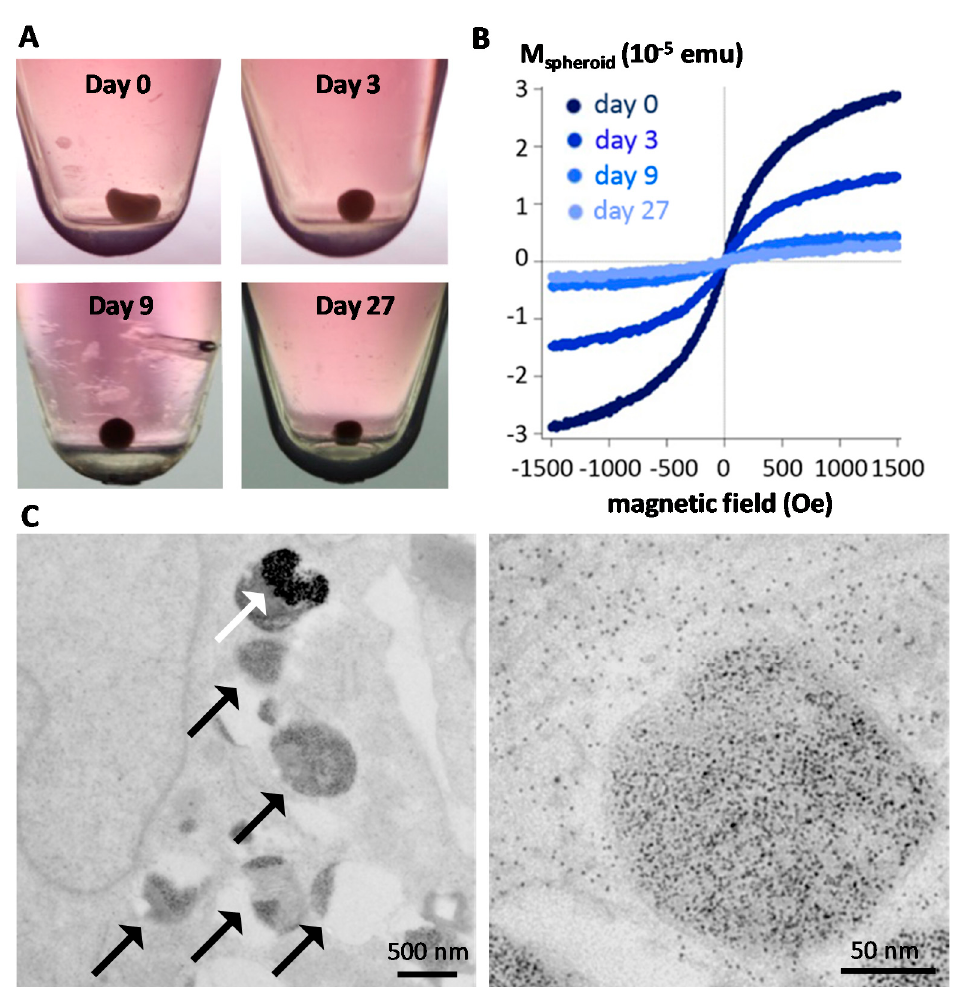
Figure 3. Intracellular biodegradation of MNPs monitored within cell spheroids as tissue model. ( A ) The spheroids are formed from 200,000 stem cells, which spontaneously regroup into a cohesive spherical aggregate that can be kept in culture over a month without experiencing any cell mortality or tissue necrosis. ( B ) Magnetometry can be performed at the single spheroid level, evidencing a massive degradation of the nanoparticles in a few days after internalization. ( C ) TEM images one month after nanoparticle internalization, demonstrating that only a few intact nanoparticles remain within the endosomes (white arrow) while both endosomes and cytoplasm are filled with the ferritin protein (black arrows) containing the iron released from degradation, with a diameter 5–7 nm as seen in the close-up image on the right. Reproduced with permission from [111] .